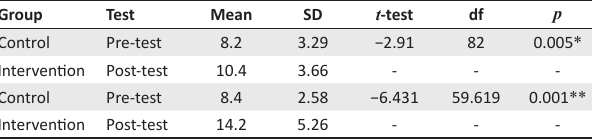
TABLE 3: Independent samples t- test (pre- and post-test of both schools) for